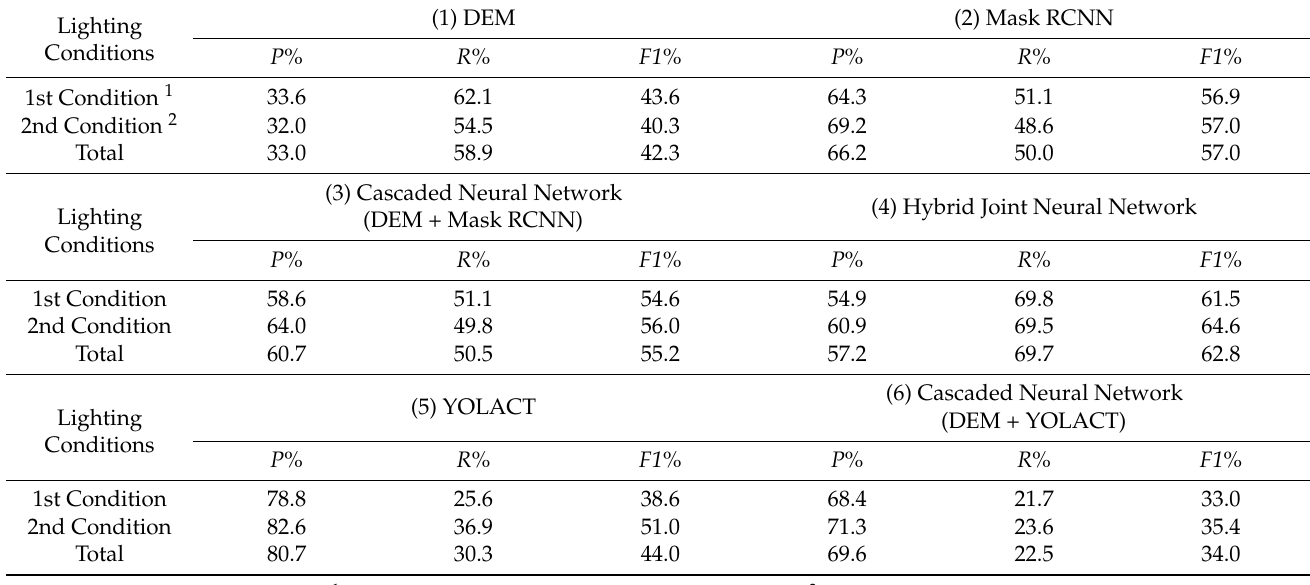
Table 2. Metric values of test results of six